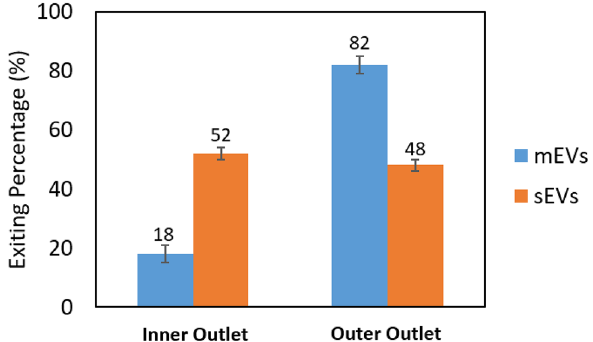
Figure 11. Results of inertial focusing test on the mixture of U87 sEVs and U87 mEVs (test B5). (a) Exiting percentage of particles from the inner outlet (left) and the outer outlet (right) (b) . n = 3, error bars = standard deviation